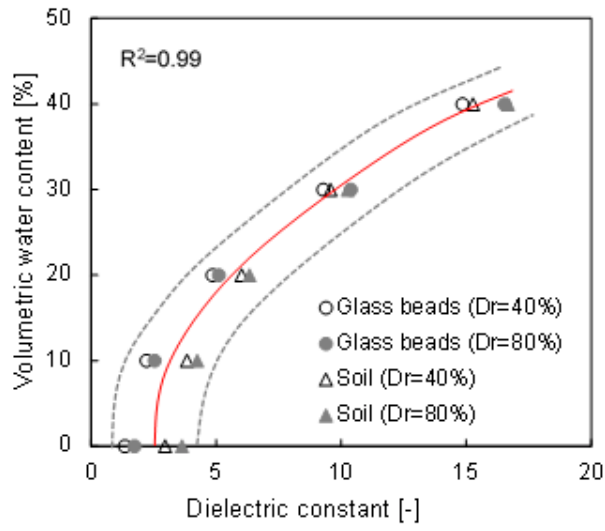
Figure 4. Calibration results between the volumetric water content and the dielectric constant. The gray dotted lines denote the boundary curves, and the red solid line is the averaged curve. The Dr denotes the relative density.